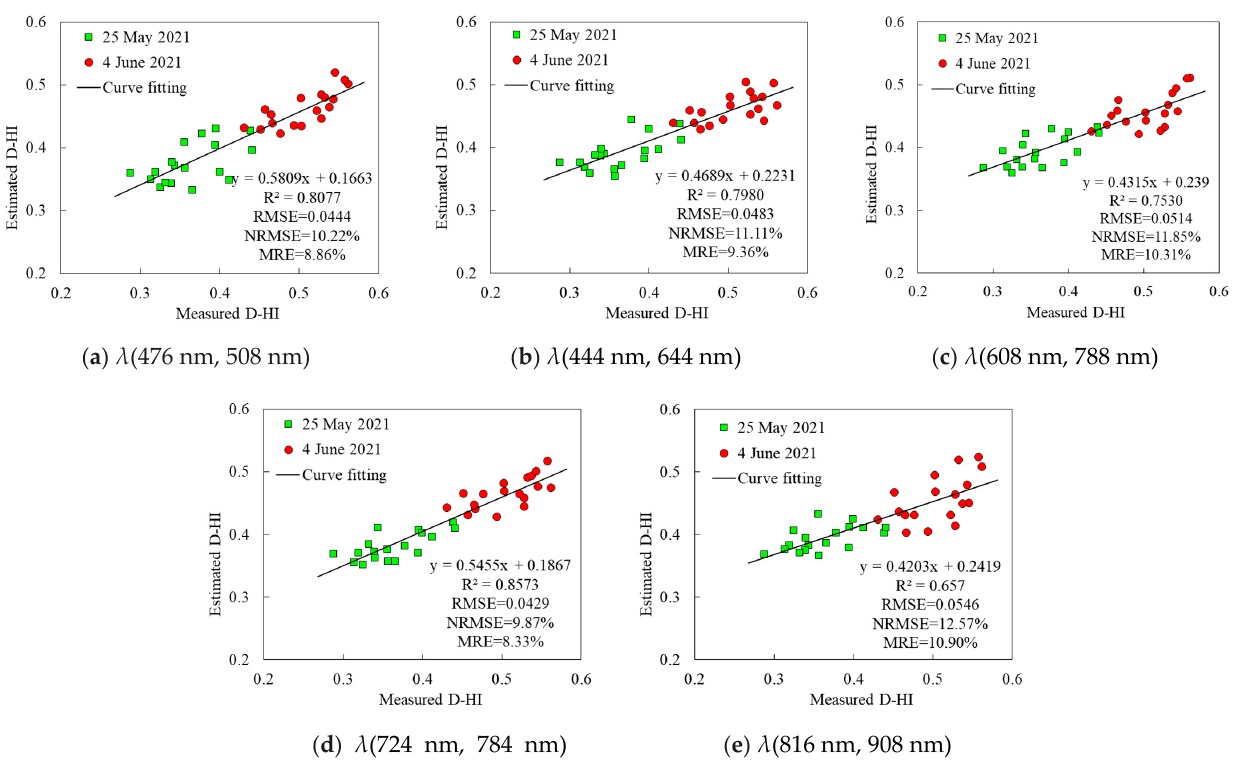
Figure 12. Validation of D-HI estimation results based on D -f G remote sensing parameters. Table 5. Statistics of spatial D-HI estimation results for each plot in different periods.